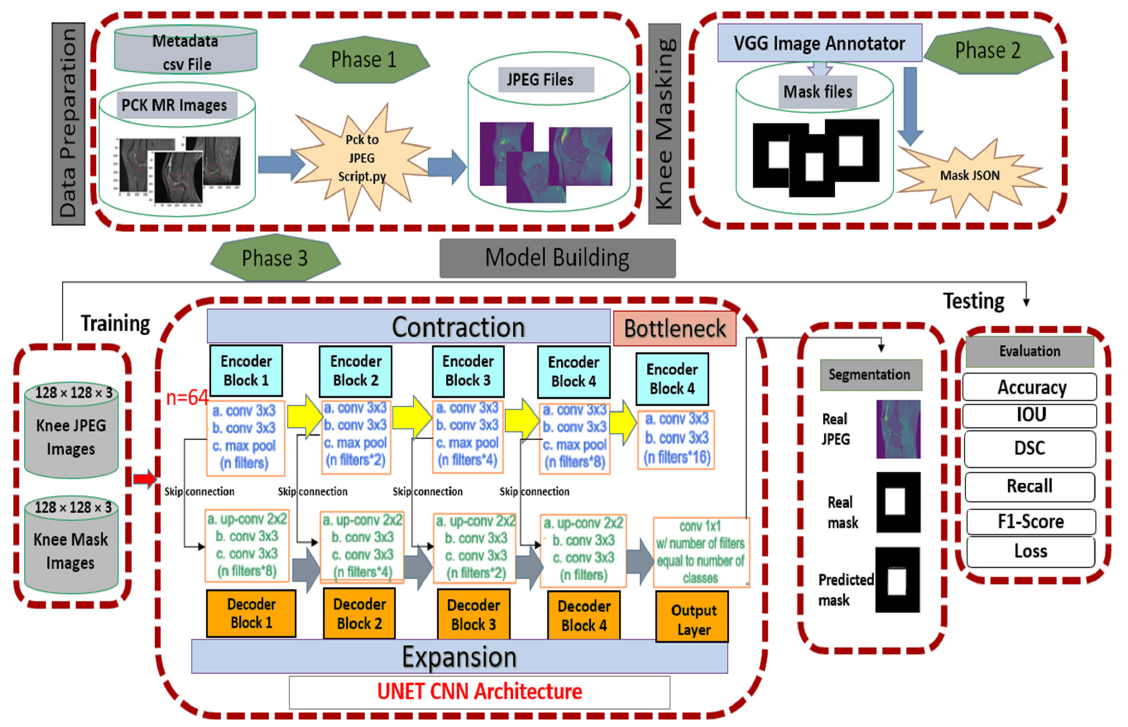
Figure 3. The segmentation framework of our proposed approach with phase 1 of data preparation, phase 2 of knee mask generation and phase 3 of model building with training and testing on our U-Net CNN architecture.